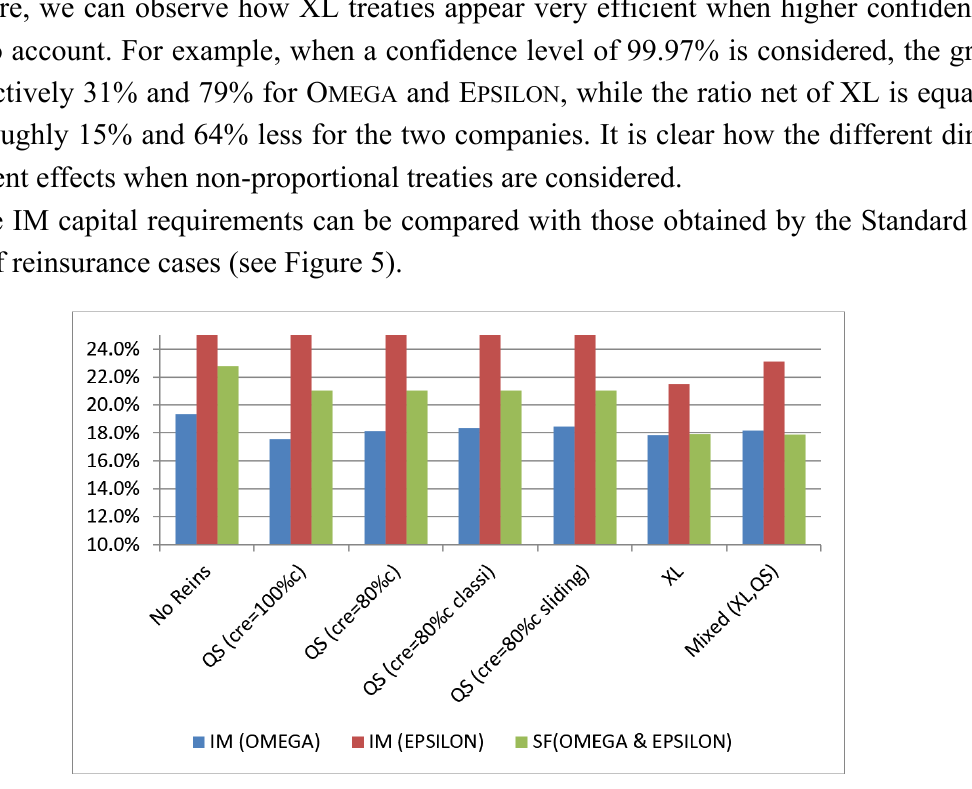
Figure 5. SCR ratios for both insurers derived by Internal Model and market-wide Standard